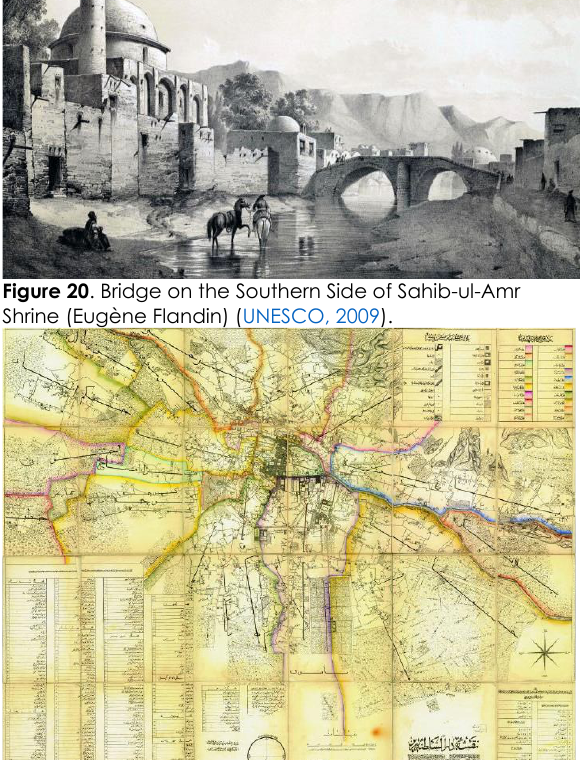
Figure 21 . Map of Tabriz Darossaltane Drawn by Sarhang Garajedāghi in 1880 A.D. ( UNESCO, 2009).